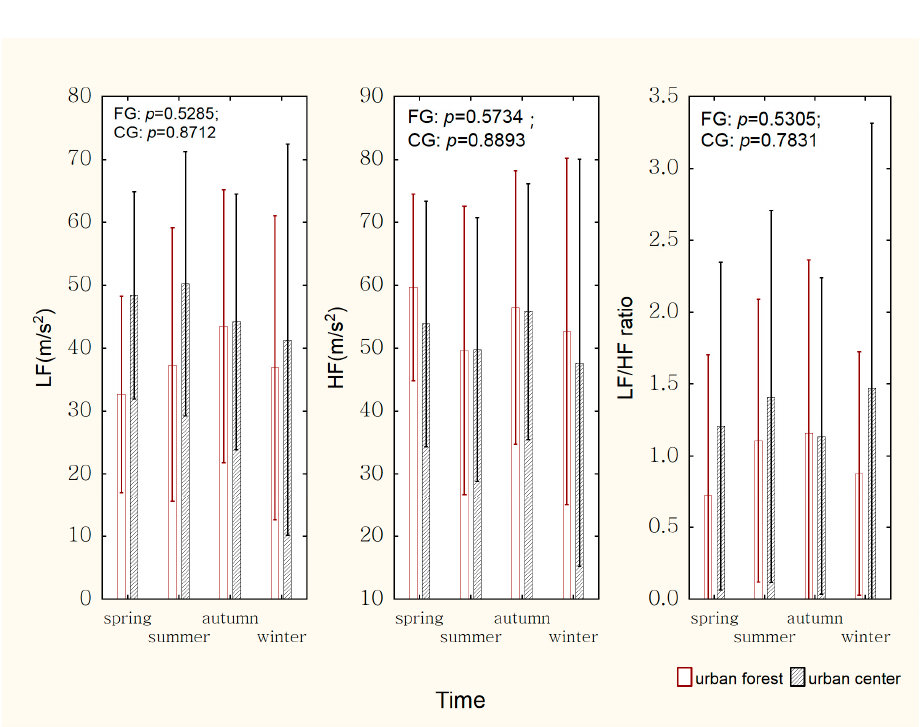
Figure 1. The heart rate variability (HRV) indicators of participants among different seasons with Kruskal–Wallis test. Mean values ± standard deviation.